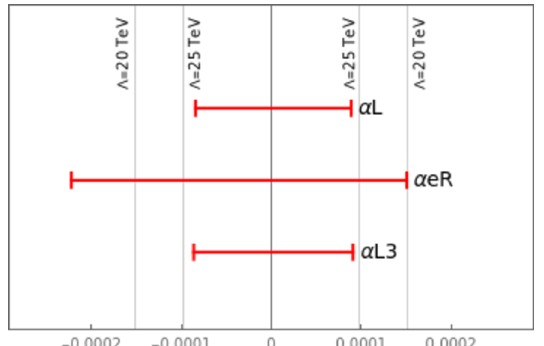
Figure 8. Projected sensitivities on the individual leptonic high-energy primaries, α e − c e v 2 / Λ 2 , α L 1 = − c l, (1) v 2 / Λ 2 α L 3 = − c l, (3) v 2 / Λ 2 , at CLIC 3000 where the other two parame- R L L ters have been marginalised over. See the text for more